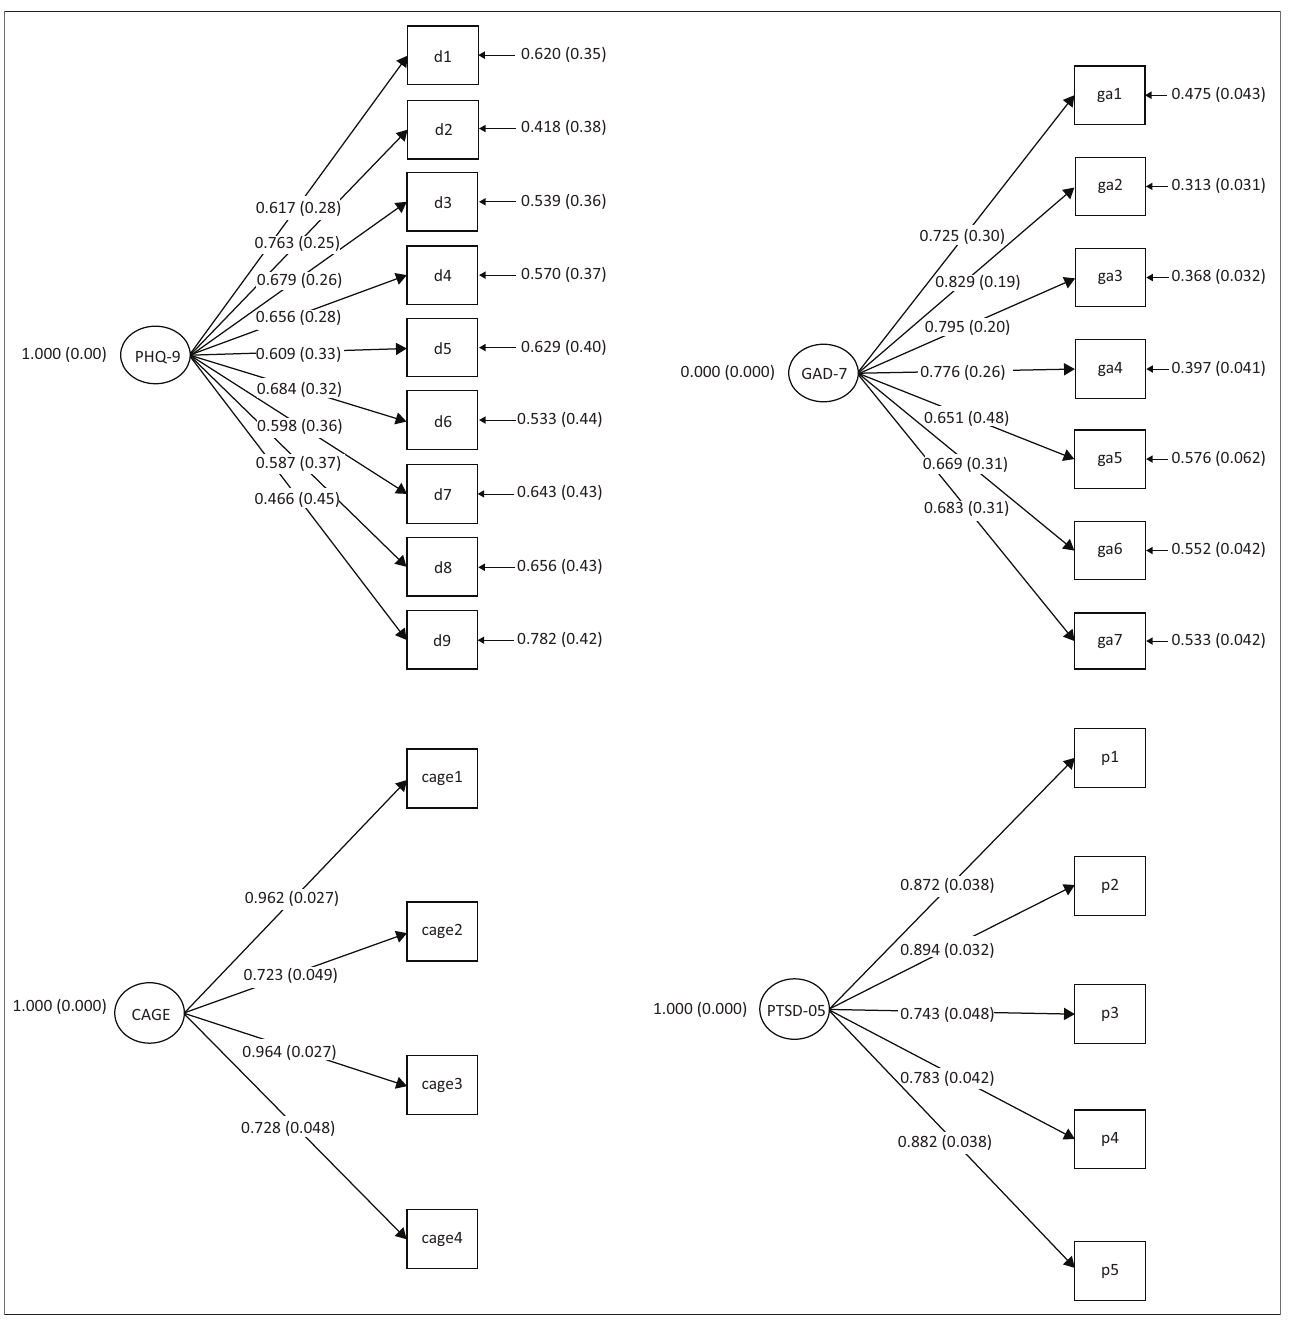
FIGURE 1: Confirmatory factor analysis results for one factor